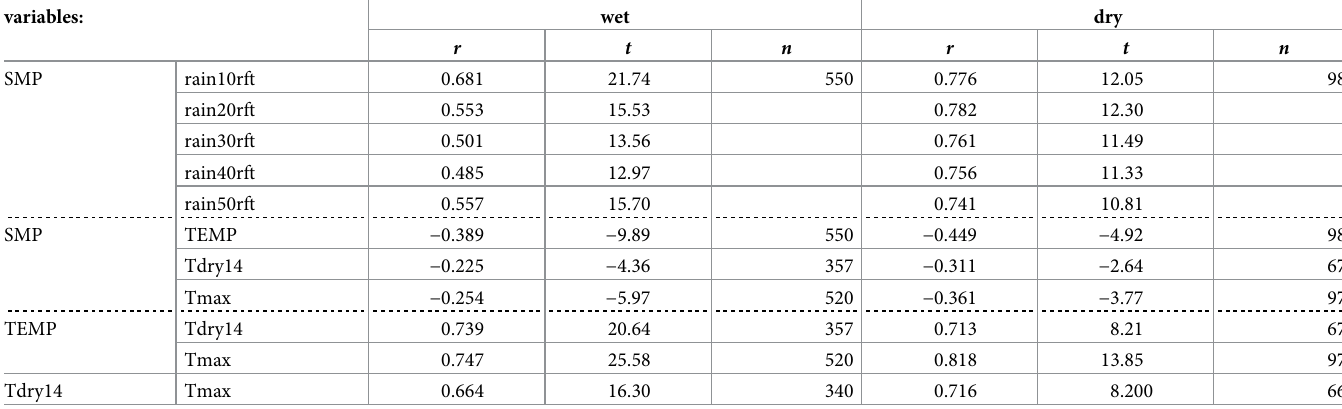
Table 3. Correlations (Pearson’s r ) between mean soil water potential, SMP [sqrt-transformed] and logger temperature at 14:00 h, TEMP, recorded at the stations); for the wet and dry periods, and climatic variables recorded at the Danum Valley Field Centre—or derived from them. The climate variables are 10-, 20-, 30-